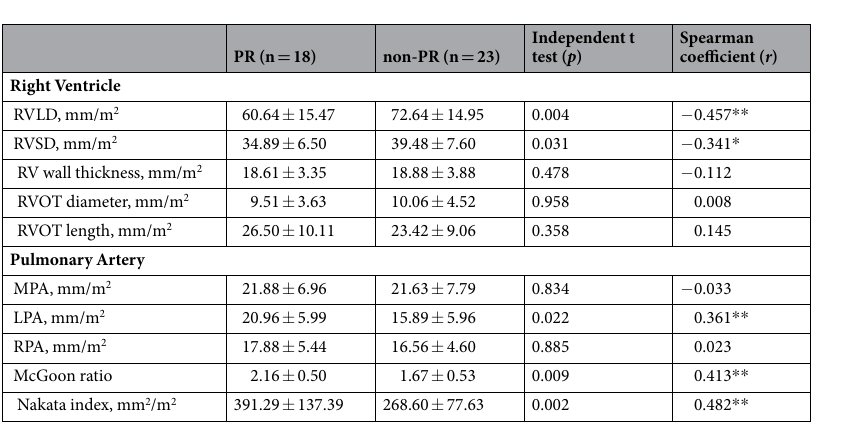
Table 2. Measurements of right ventricular and pulmonary artery by DSCT compared to post-operative pulmonary regurgitation in patients with trans-valve surgery. Note: Data given as the mean ± SD. RV, Right ventricle; RVLD, right ventricular length diameter; RVSD, right ventricular short diameter; RVOT, right ventricular outflow tract; MPA, main pulmonary artery; LPA, left pulmonary artery; RPA, right pulmonary artery. * p < 0.05; ** p <